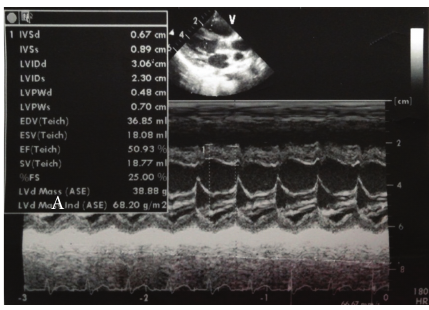
Figure 1: The echocardiographic findings on the second day of admission show decreased fractional shortening (25%) of left